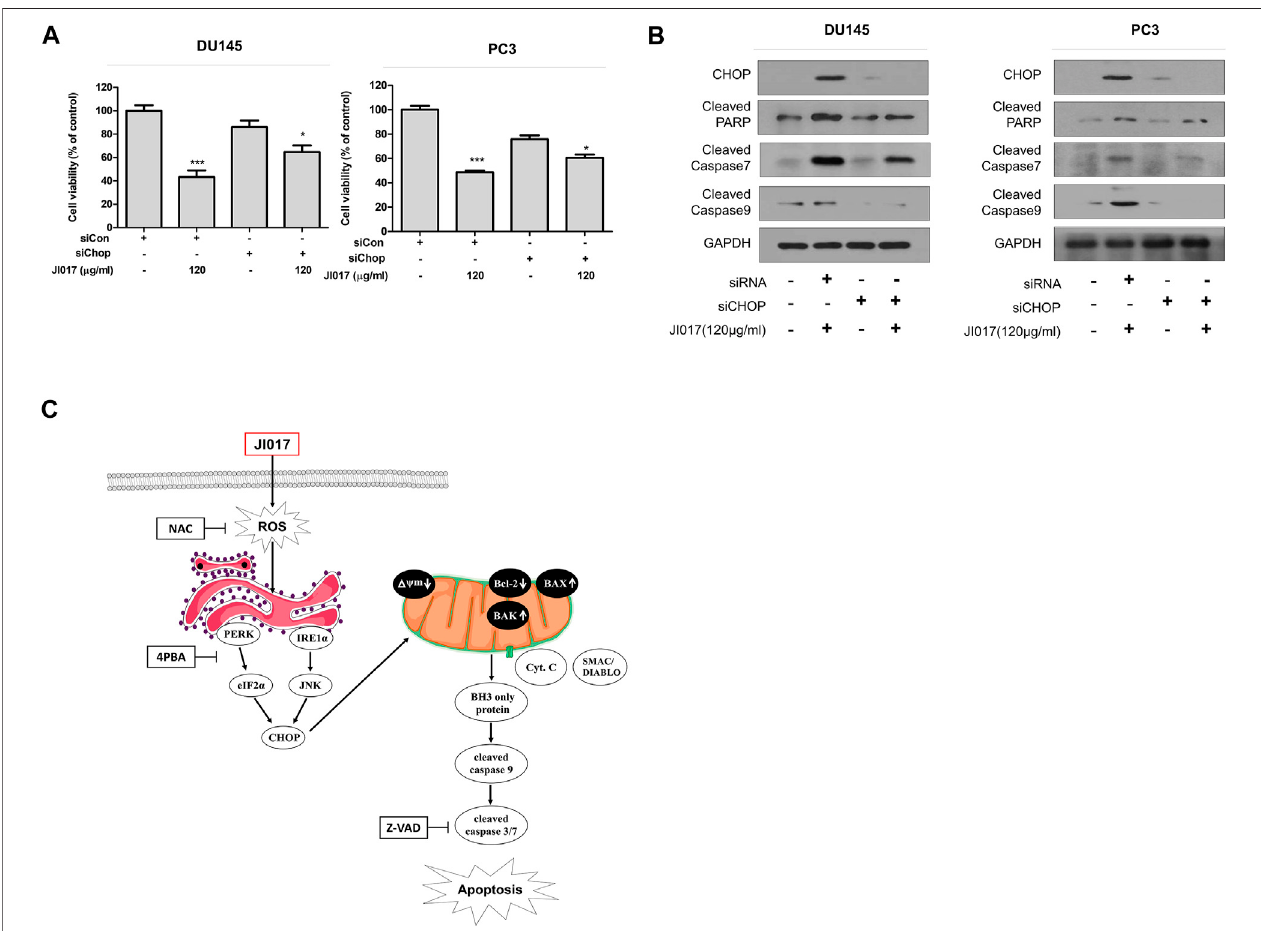
FIGURE7| Knockdown ofCHOP signaling blocks apoptosis induced byJI017 treatment ofprostate celllines.DU145 and PC3 cells weretransfectedwithCHOP siRNA and treated with JI017. Cell viability was measured by the MTS assay (A) . Whole cell lysates were analyzed by western blotting with anti-CHOP, anti-cleaved caspase-3, anti-cleaved caspase-7, anti-cleaved caspase-9, anti-CHOP, and anti-GAPDH antibodies (B) . Schematic representation of JI017 treatment of prostate cancer cells (C) . The data are presented as the mean ± SEM. * p < 0.05, ** p < 0.01, and *** p < 0.001 compared to untreated cells.